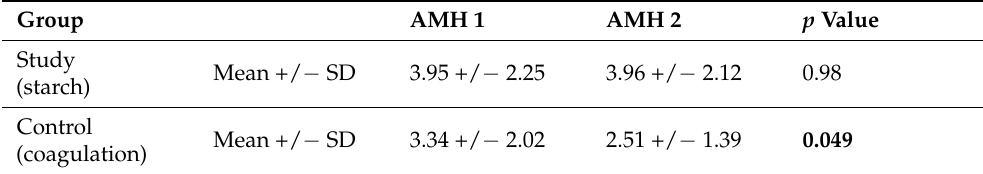
Table 4. Comparison of AMH levels before surgery and 6 months after surgery.